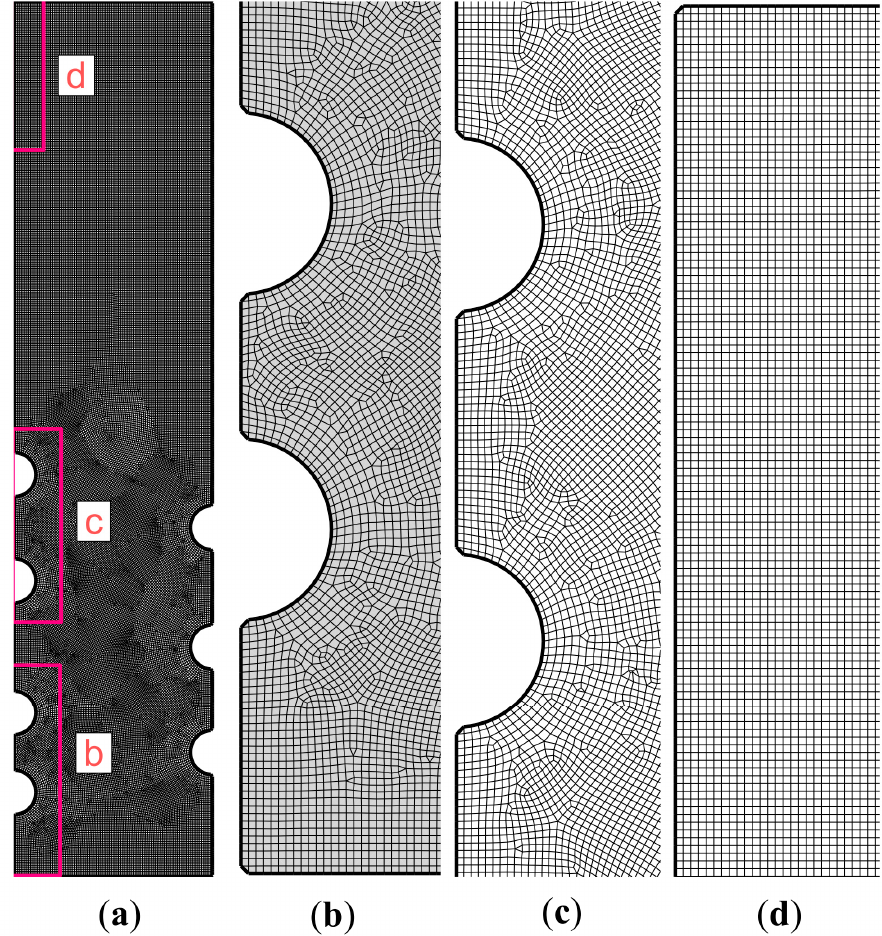
Figure 3. A view of the computational mesh for a case with 50,500 cells: ( a ) The overall mesh; ( b ) the mesh in part b around bottom tubes; ( c ) the mesh in part c around top tubes; ( d ) the mesh in part d at the top corner.